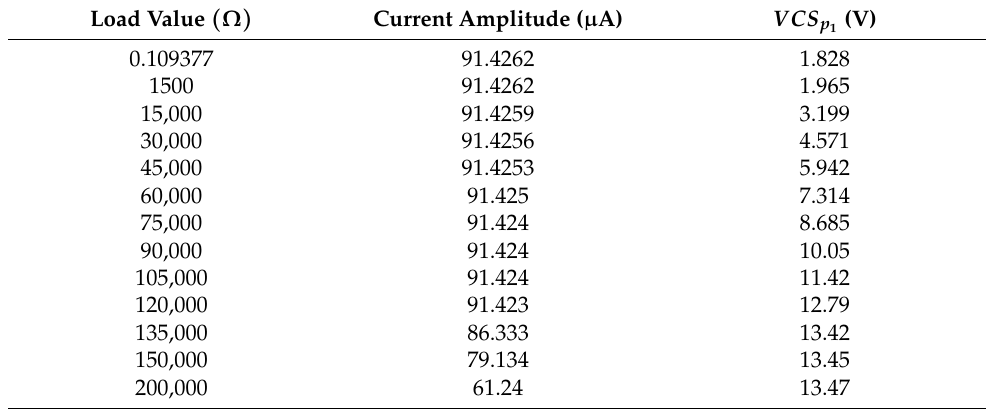
Table 2. Measurements for output current sensitivity to load impedance changes